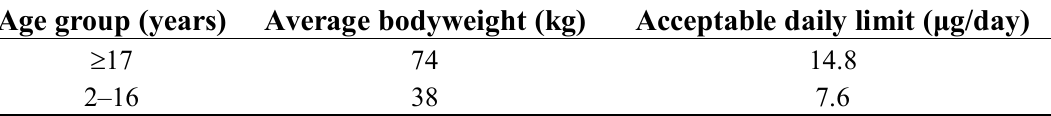
Table 4. Acceptable daily limit for microcystins with age and bodyweight.